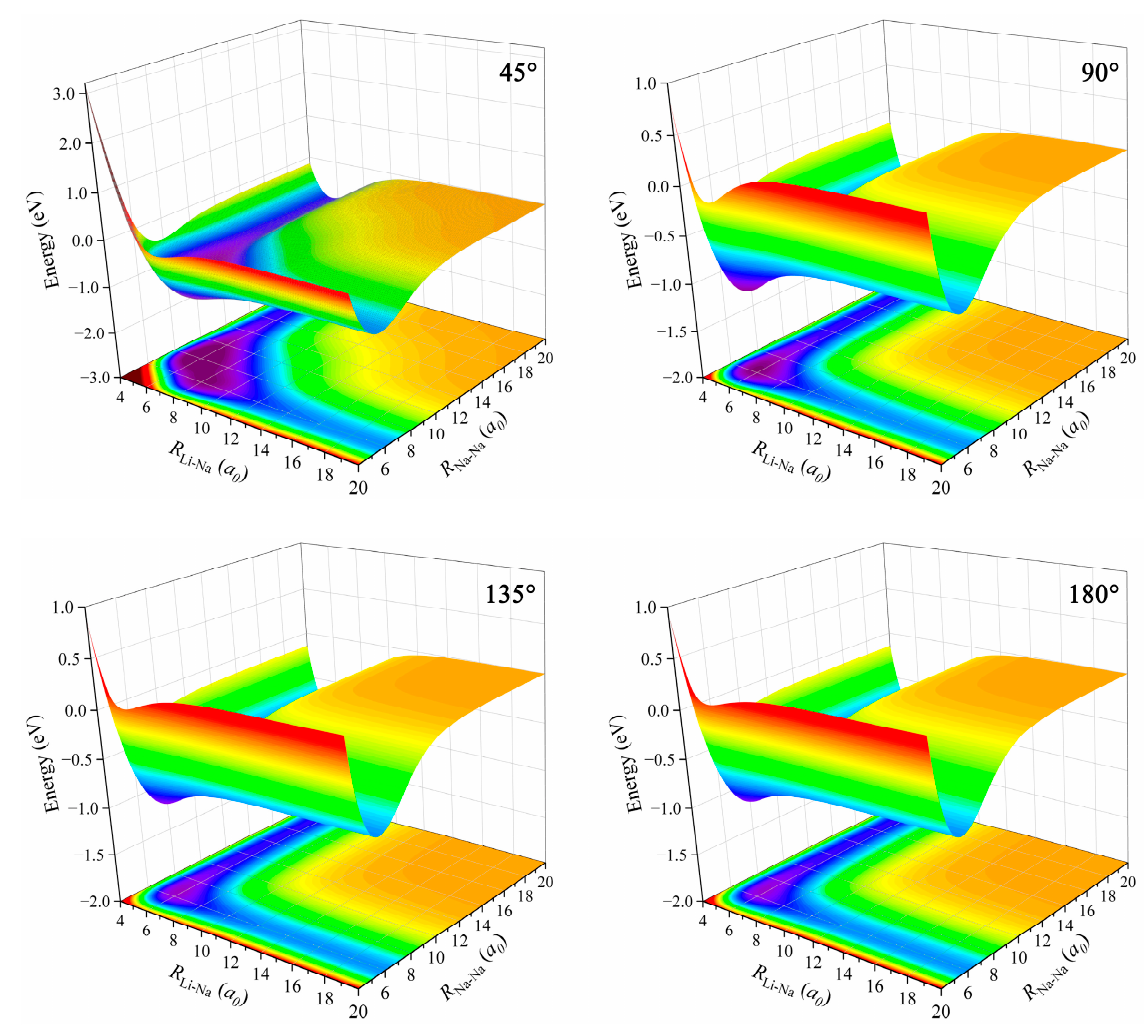
Figure 4. Three-dimensional diagrams and the corresponding contour maps of the ground-state Figure 4. Three − dimensional diagrams and the corresponding contour maps of the ground − state LiNa 2 PES at fixed Li–Na–Na angles (45 ◦ , 90 ◦ , 135 ◦ and 180 ◦ LiNa 2 PES at fixed Li − Na − Na angles (45°, 90°, 135° and 180°).